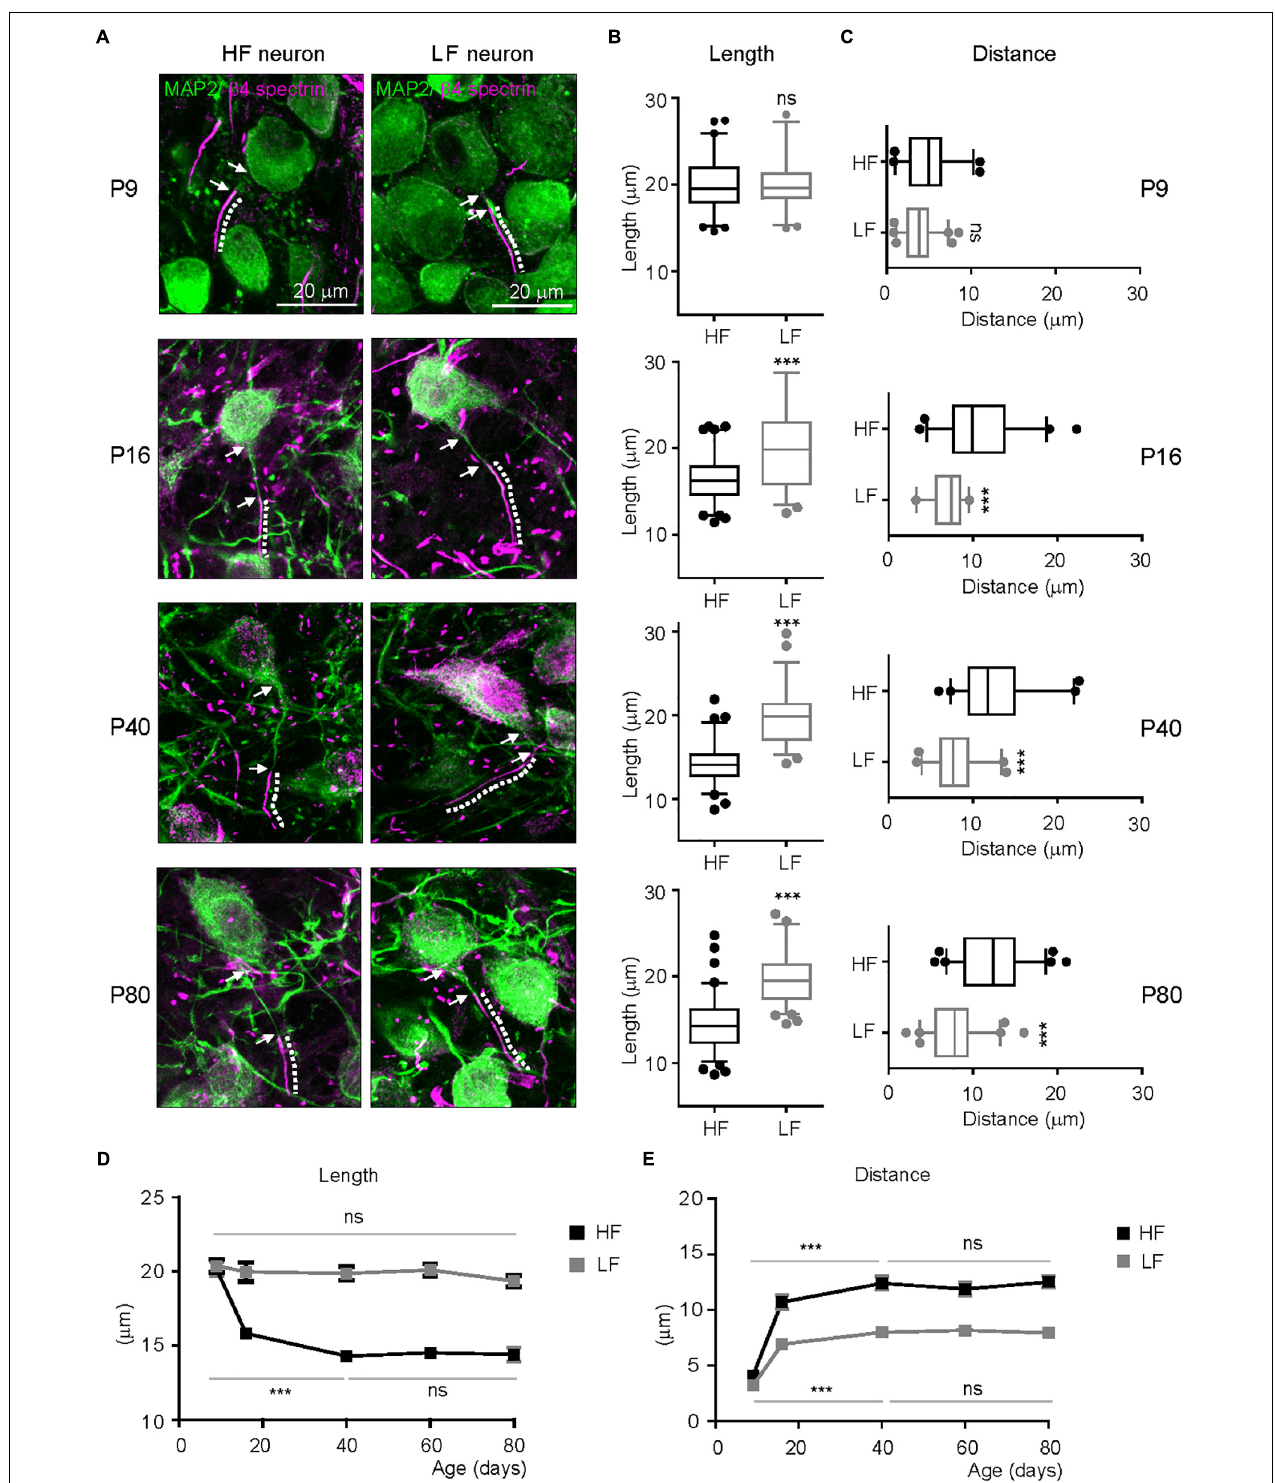
FIGURE 3 | Developmental refinement of AIS structure and tonotopy in the MNTB. (A) Representative images of HF and LF neurons, which were immunostained with MAP2 (green) and β 4spectrin (magenta) at P9, P16, P40, and P80. The dotted line and white arrow indicate AIS length and distance, respectively. (B,C) Summary of AIS length and location in HF (black) and LF (gray) neurons of the MNTB at P9, 16, 40, and 80. Note, the significant difference in AIS length and location between HF and LF neurons appears at P16 after hearing onset. ∗∗∗ P < 0.0001, Mann–Whitney U test or unpaired t -test. (D,E) The plot of AIS length and distance of HF (black) and LF neurons (gray) along postnatal ages (from P9 to P80). ∗∗∗ P < 0.001, Kruskal–Wallis test with Dunn’s post hoc test.